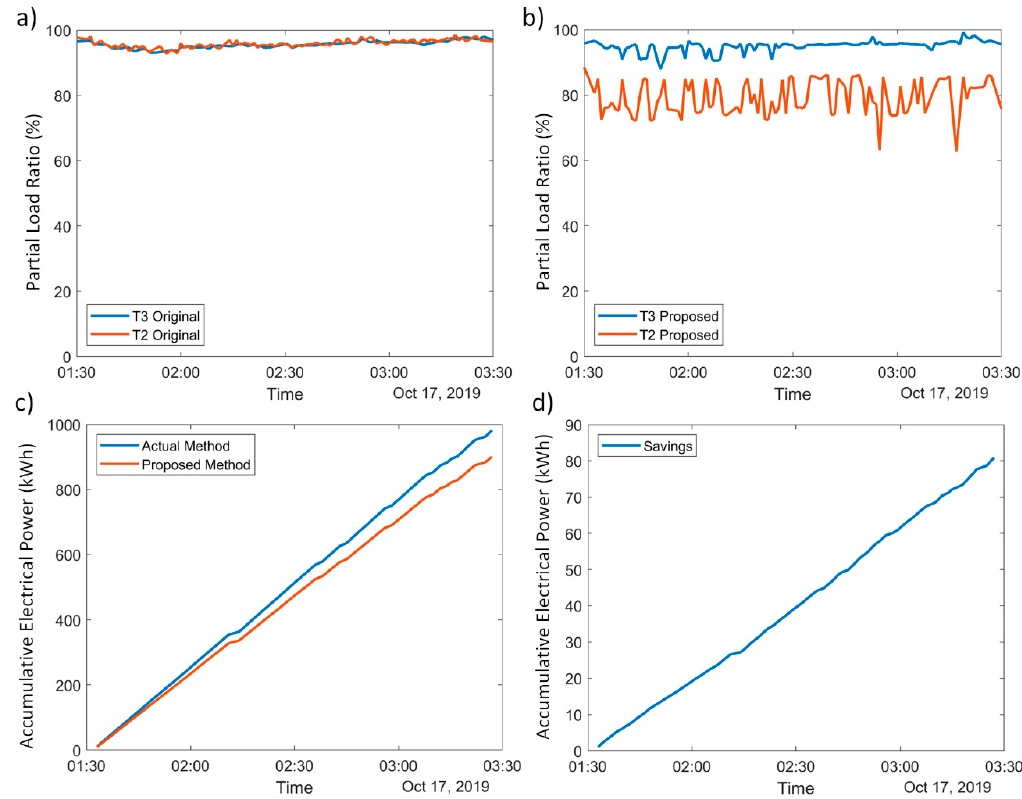
Figure 8. Comparison of the actual control and the proposed methodology in the scenario where two compressors are needed. ( a ) Actual PLRs control strategy. ( b ) Proposed methodology PLRs. ( c ) Accumulative electrical power consumed by the actual control and the proposed method. ( d ) Accumulative savings in kWh of the proposed method.